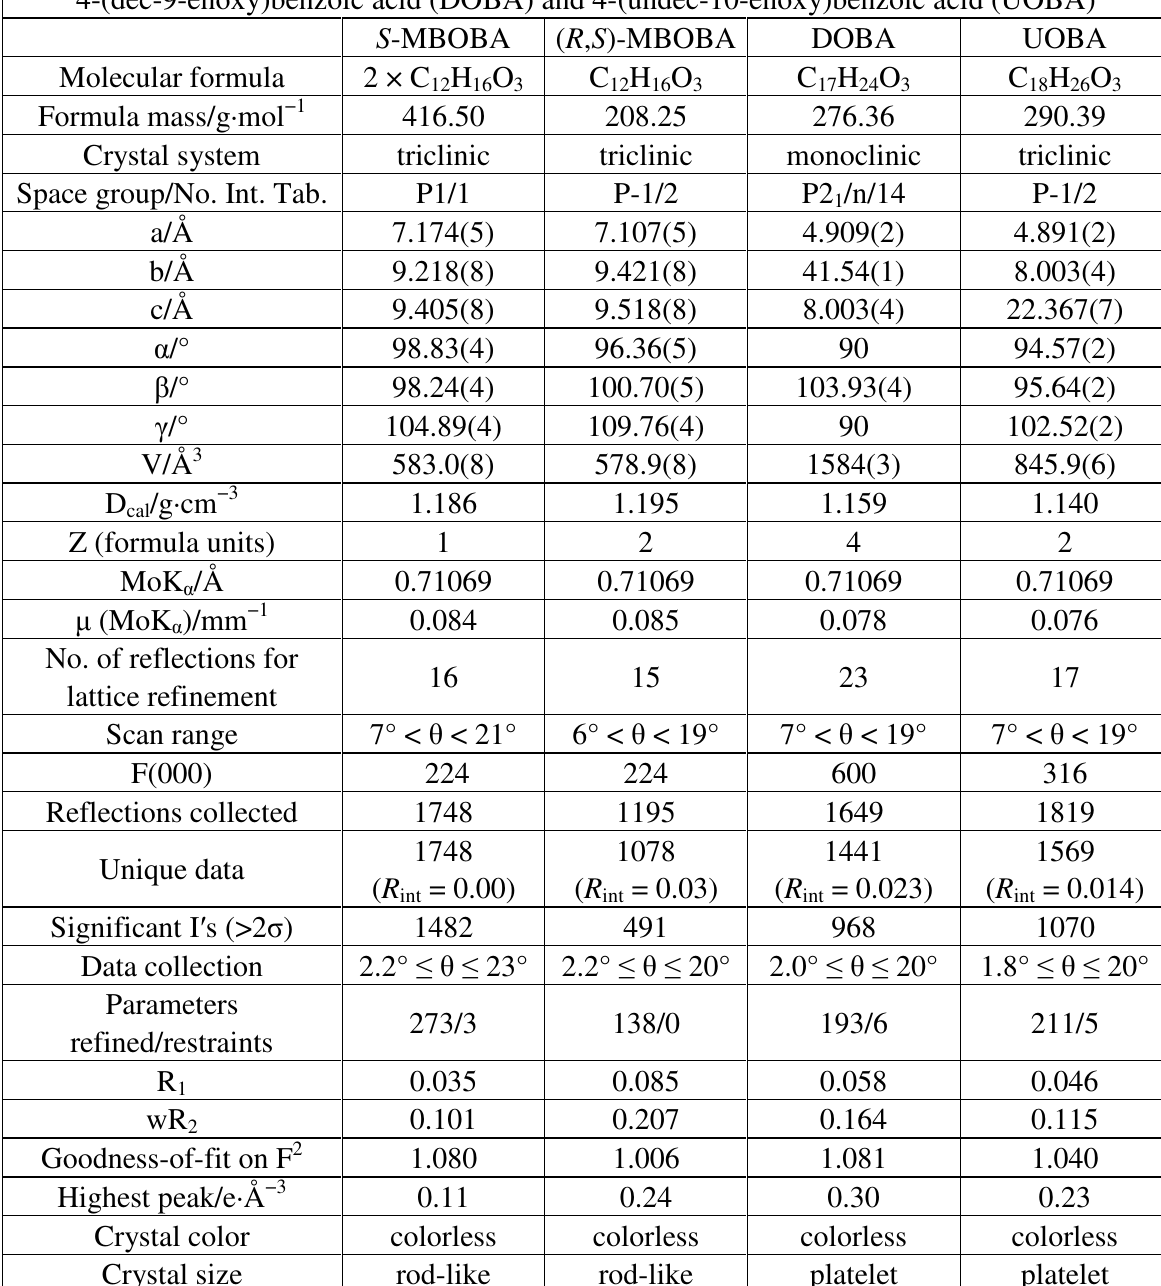
Table 4. Summary of crystallographic data of some 4-substituted benzoic acids collected at ambient